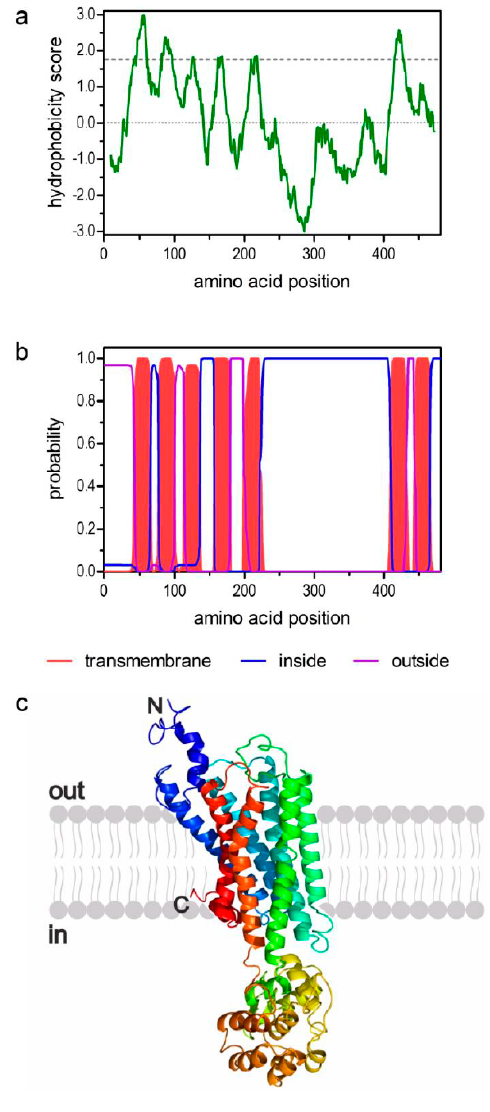
Figure 1. Structural characteristics of the deduced amino acid sequence of PeaTAR1B. ( a ) Hydrophobicity profile of PeaTAR1B. The profile was calculated according to the algorithm of Kyte and Doolittle [75] using a window size of 19 amino acids. Peaks with scores greater than 1.6 (dashed line) indicate possible transmembrane regions; ( b ) Prediction of transmembrane domains with TMHMM server v. 2.0 [76]. Putative transmembrane domains are indicated in red. Extracellular regions are shown as purple line, intracellular regions as blue line; ( c ) Color-coded (rainbow) 3D model of the receptor as predicted by Phyre2 [77]. The extracellular N-terminus (N) and the intracellular C-terminus (C) are labeled.